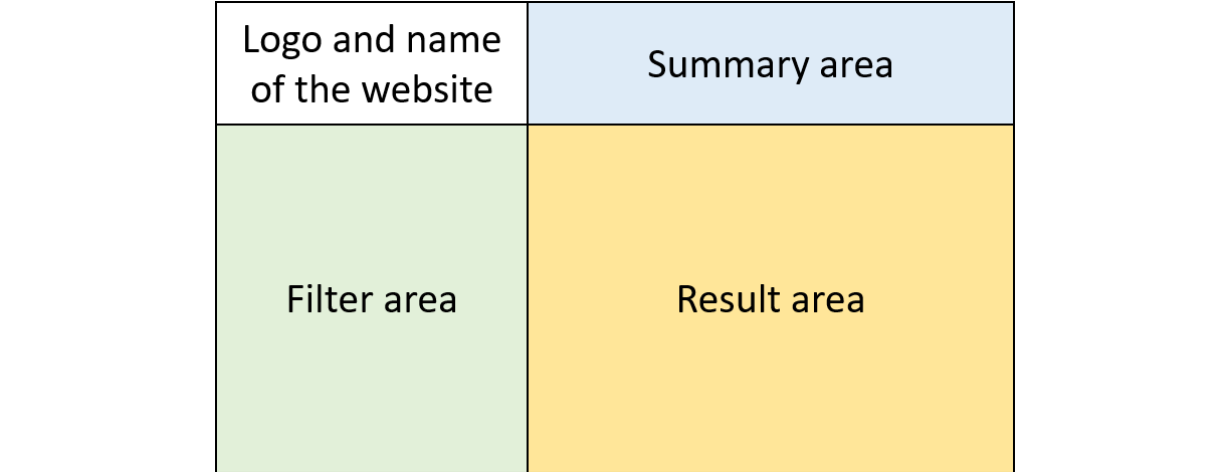
Figure 1. Basic wireframe of e-commerce interfaces compartmentalized into sections.